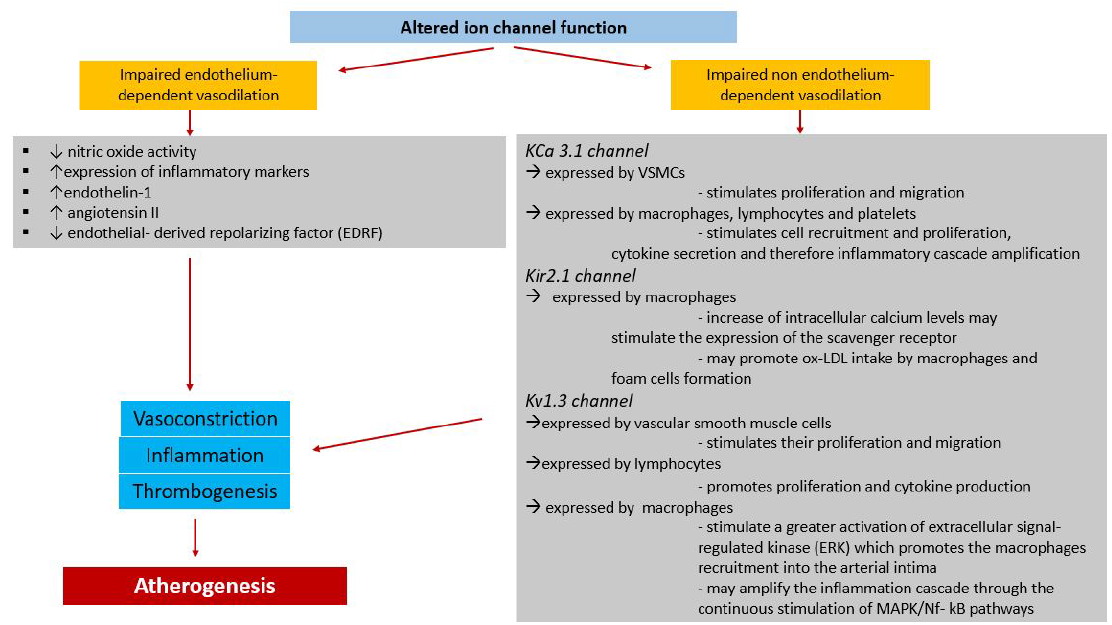
Figure 4. Contribution of altered ion channel function to the pathophysiology of atherogenesis. In coronary circulation, ion channels contribute to both endothelium-dependent and non-endothelium-dependent vasodilation. When ion channel function is impaired, the vasodilating effect is decreased, affecting both pathways. In the left side of the figure (grey box), molecules and proteins involved in the impaired endothelium-dependent vasodilation are listed. These pathways are responsible of vasoconstriction, inflammation, and thrombogenesis. On the right (grey box), there is a focus on the main K channels involved in the amplification of the inflammatory cascade through the augmented proliferation and migration of lymphocytes, macrophages, and platelets. All these mechanisms contribute to atherogenesis.